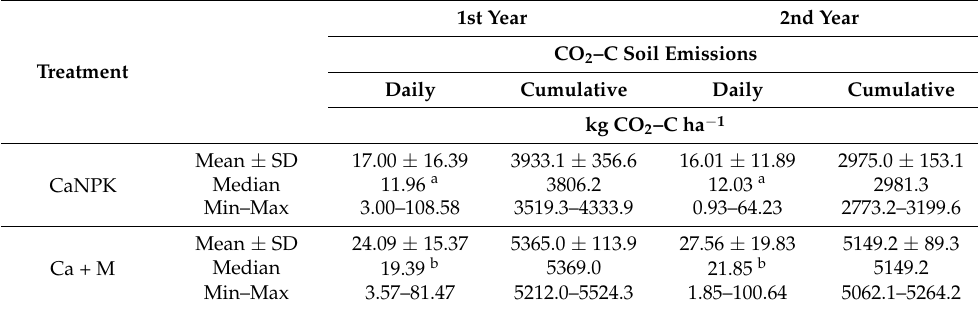
Table 3. Daily and cumulative CO 2 –C emissions from the soil in the CaNPK and Ca + M treatments under a rye monoculture over the measurement period.